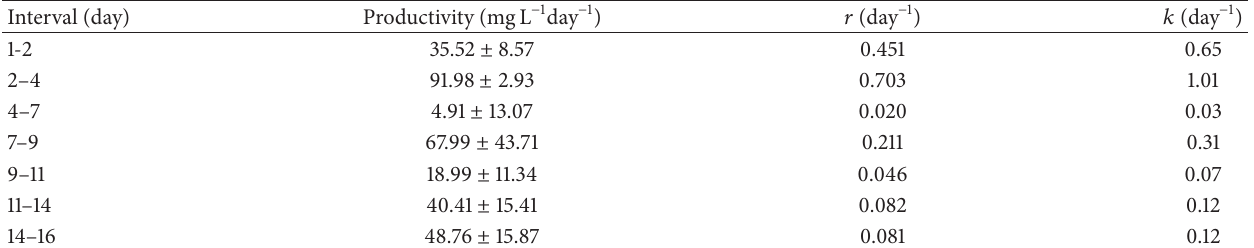
Table 1: Productivity, growth rate, and duplications per day in the microalgae culture.